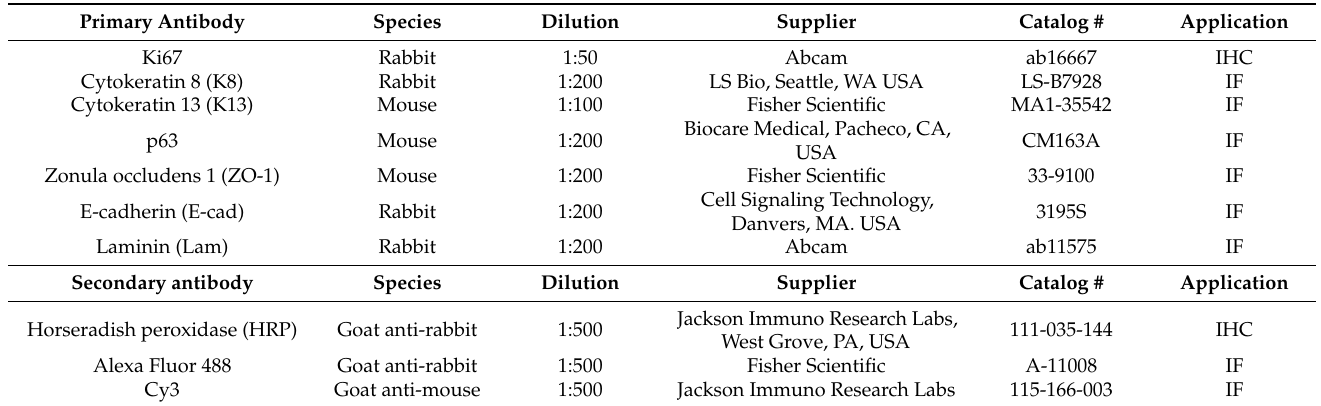
Table 1. Primary and secondary